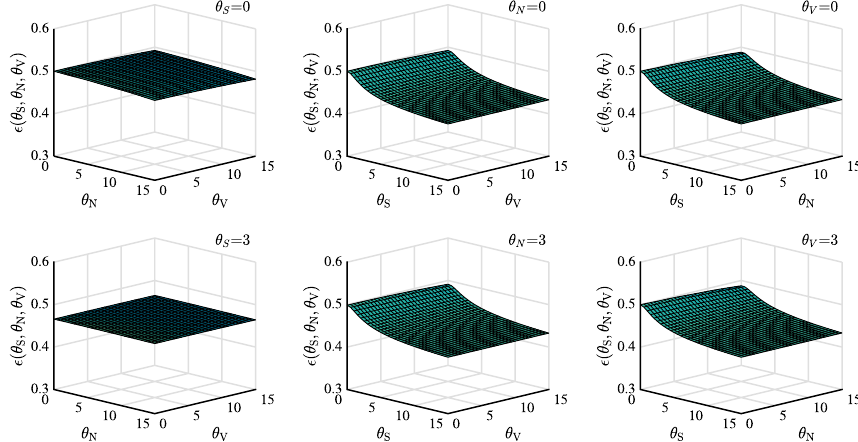
Fig. 6 DEP in Bitcoin market as a function of ambiguity parameters θ S , θ V and θ N . Panel ( a ), ( b ), and ( c ) set θ S , θ N , and θ V as 0, respectively. By contrast, Panel ( d ), ( e ), and ( f ) set θ S , θ N , and θ V as 3, respectively